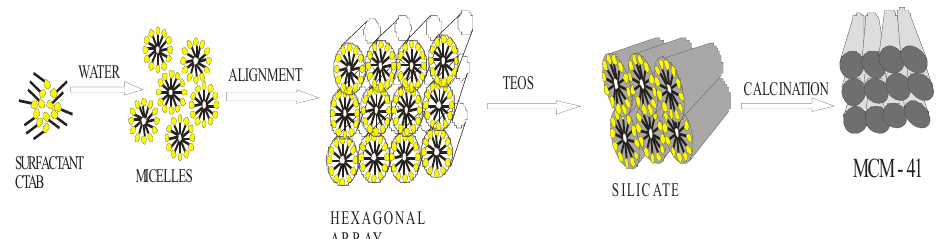
Figure 18. Synthetic scheme for MCM-41 materials.